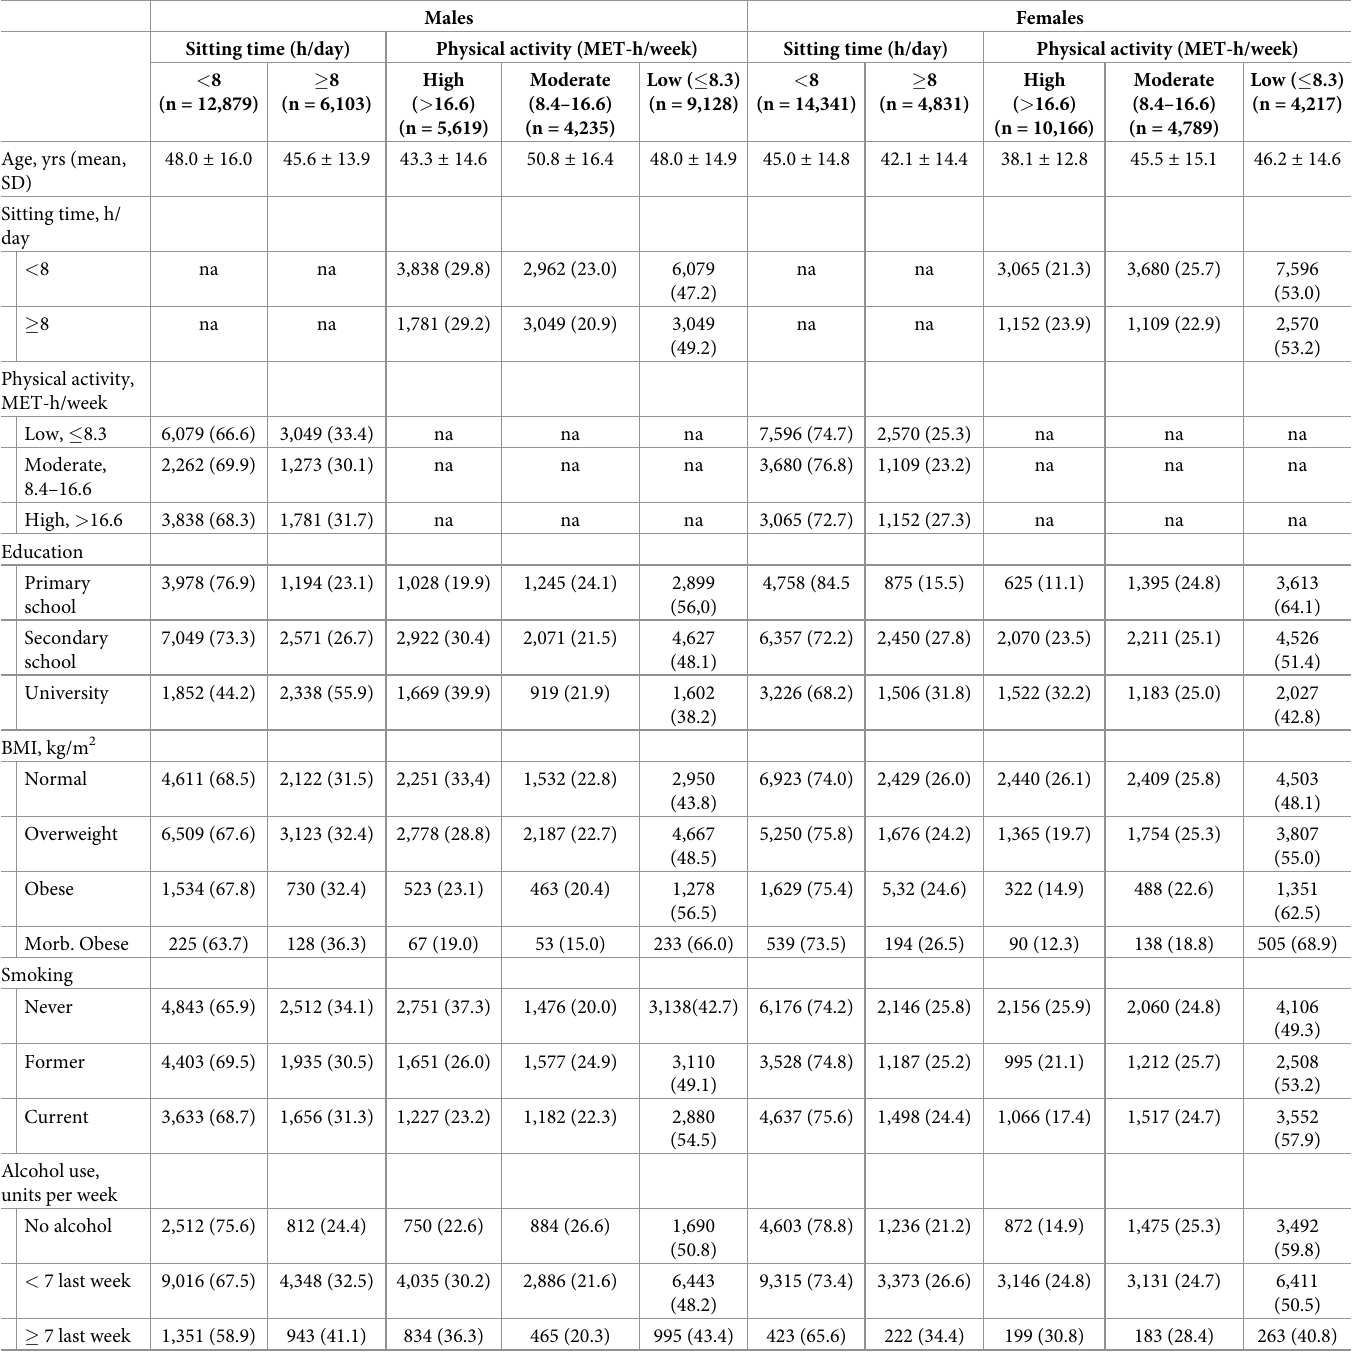
Table 1. Baseline characteristics stratified by sex, sitting time and physical activity (n = 38 155). Males